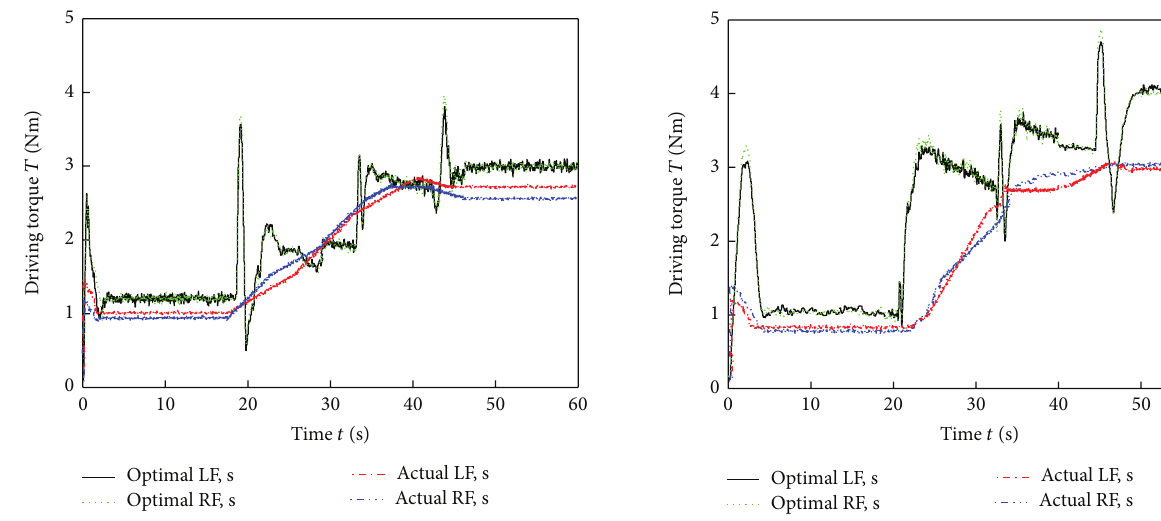
Figure 15: Behind-wheels driving torque comparison of different control strategy.